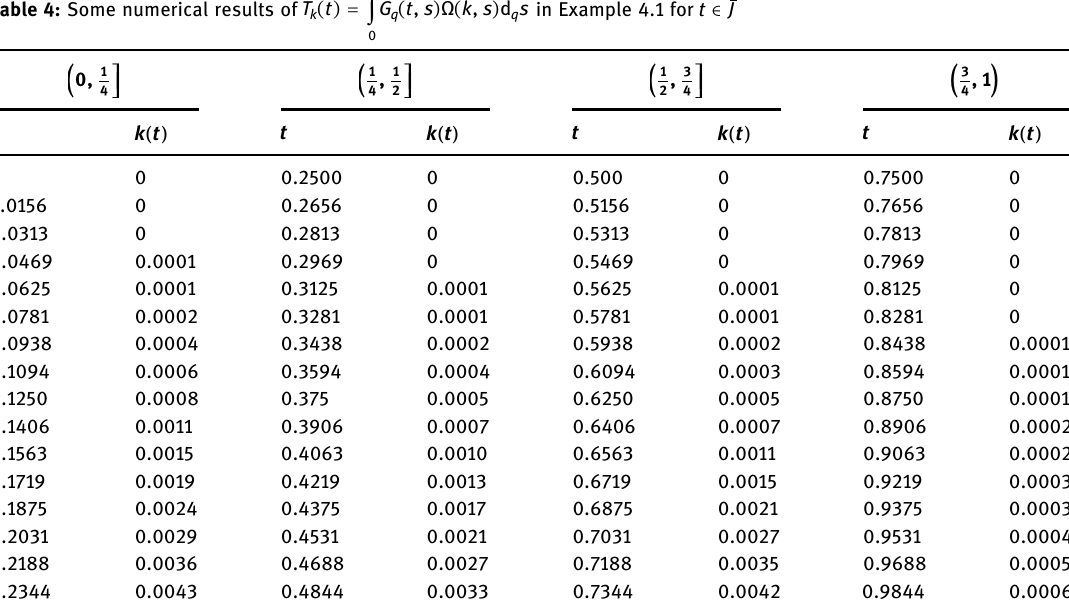
Table 4: Some numerical results of (